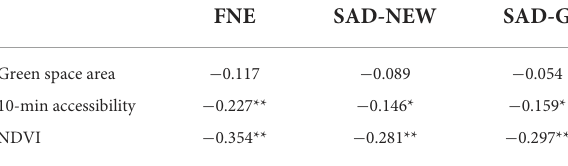
TABLE 2 Correlation results of social anxiety and spatial environment.